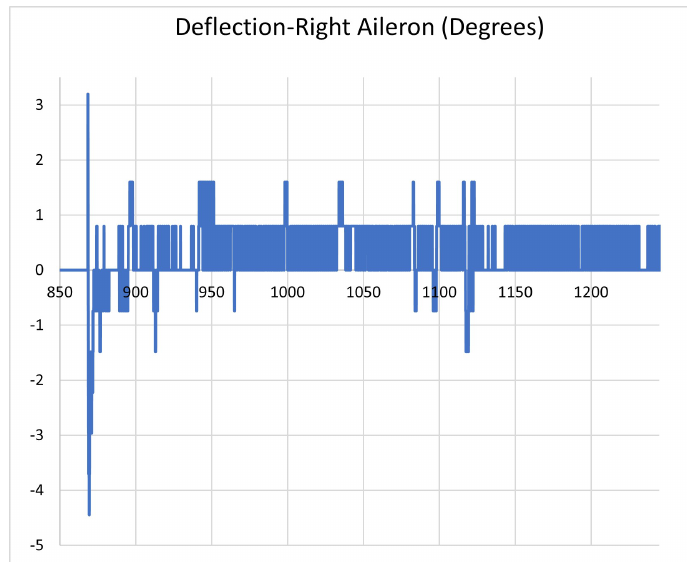
Figure 1. Aileron Deflection.